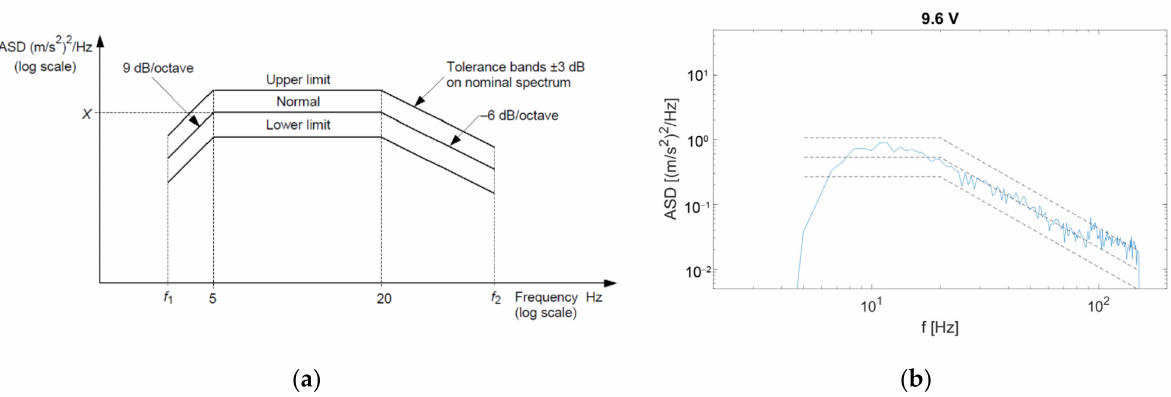
Figure 2. ( a ) Shape of acceleration spectral density according to IEC 61373. ( b ) Acceleration spectral density as measured in our setup with an RMS output voltage of the amplifier of 9.6